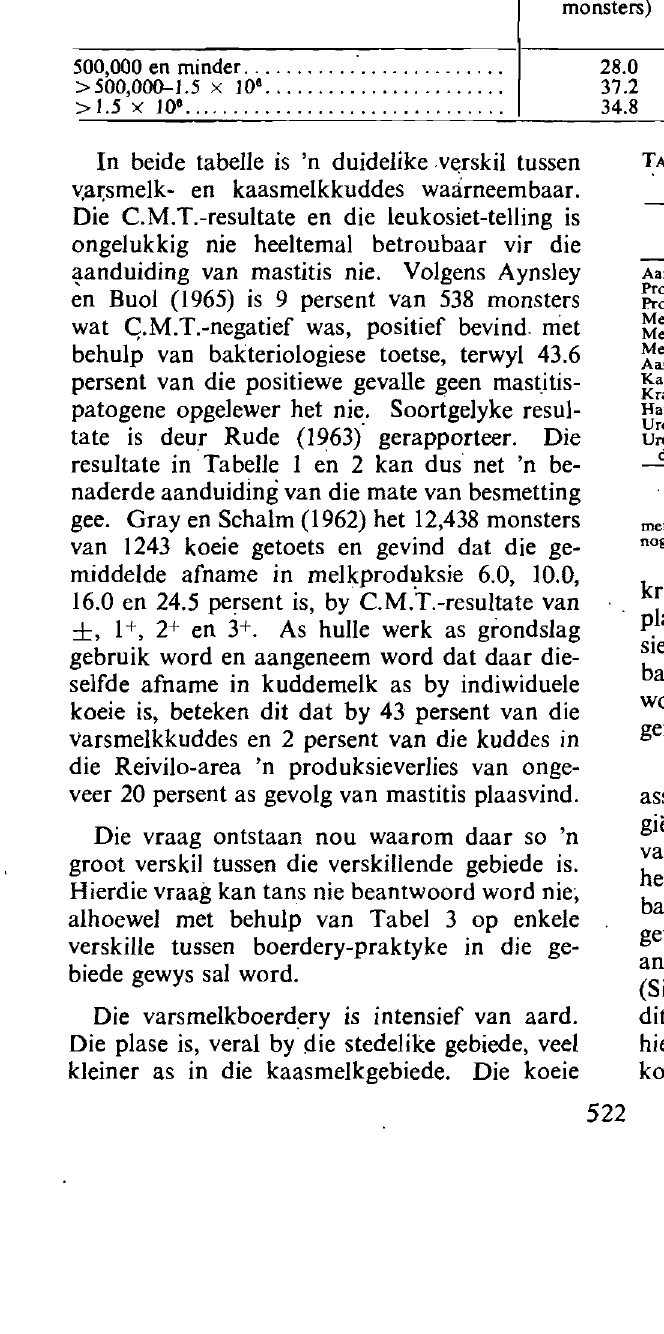
TABEL 2.-MASTITIS-VOORKOMS IN MELKKUDDES, SOOS AANGEDUI DEUR MIDDEL VAN LEUKOSIETE TELLINGS • Kaasmelkkuddes by Varsmelkkuddes Aantal leukosiete